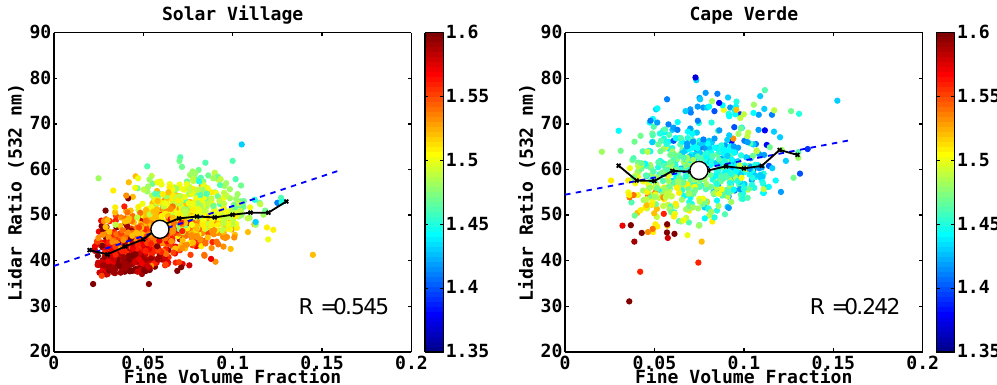
Fig. 11. AERONET-retrieved lidar ratio as a function of fine volume fraction for two dust sites; color code represents the retrieved real refractive index. Dataset is constrained to months May through September and depolarization ratios greater than 0.2. Dashed blue lines correspond to linear regressions. Solid black lines represent medians at each fine volume fraction, and the large circles represent medians of the respective datasets. Note that the Solar Village median lidar ratio is lower than the Capo Verde median lidar ratio because Solar Village dust has higher refractive indices (see colorcode).